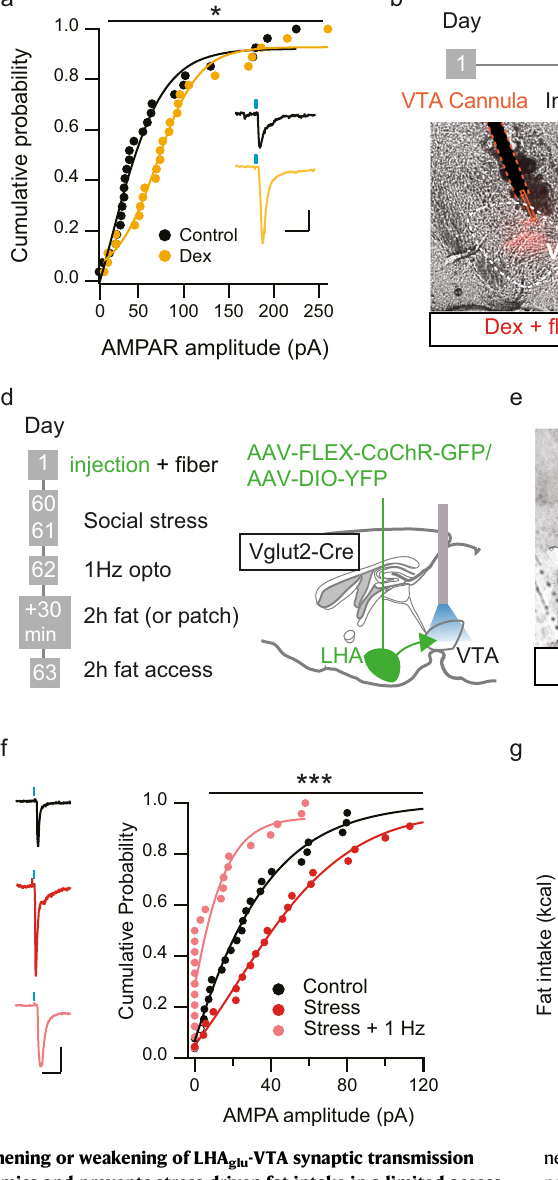
neurons. Scale bar: 100 µ m. Anatomical reference point: f fornix. f Cumulative probability of LHA glu -VTA opto-evoked AMPAR amplitudes for control, stress and stress + in vivo opto 1Hz 30min stimulation conditions. In vivo 1Hz 30min sti- mulationsigni fi cantlydecreasestheAMPAamplitude,whencomparingstresswith and without stimulation ( n cells control=26, n cells stress=22, n cells stress +1Hz=24,KS-test, D =0.61, p =0.0002).Scalebars:25pA,25ms. g Totalfatintake (kcal) on PSD1 and PSD2 in 2h access increased after stress in YFP control condi- tions,butnotinCoChRconditions(averages+SEMs,nanimalsYFP-control=30, n animals YFP-stress=30, n animals CoChR-control=21, n animals CoChR-stress= 19. RM Two-way ANOVA. Interaction stress X Virus type F (1,96) =7.16, p =0.009;